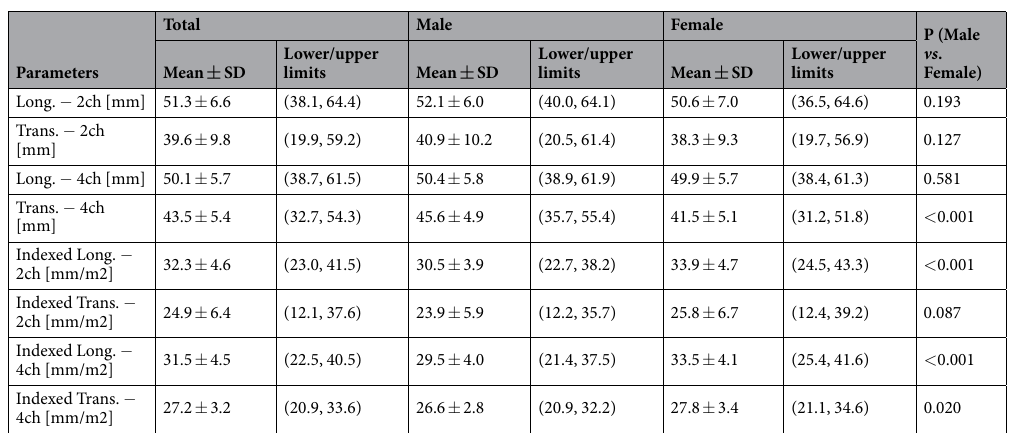
Table 5. Total and gender specific right atrial dimension parameters (mean ± SD, and reference range) (n = 135). Lower/upper limits calculated as mean ± 2 SD; Long., Longitudinal dimension; Trans, Transverse dimension; AP, Antero-posterior dimension; 2ch, 2-chamber view; 3ch, 3-chamber view; 4ch, 4-chamber view; Indexed dimensions are calculated by corresponding dimensions in mm divided by BSA in m 2